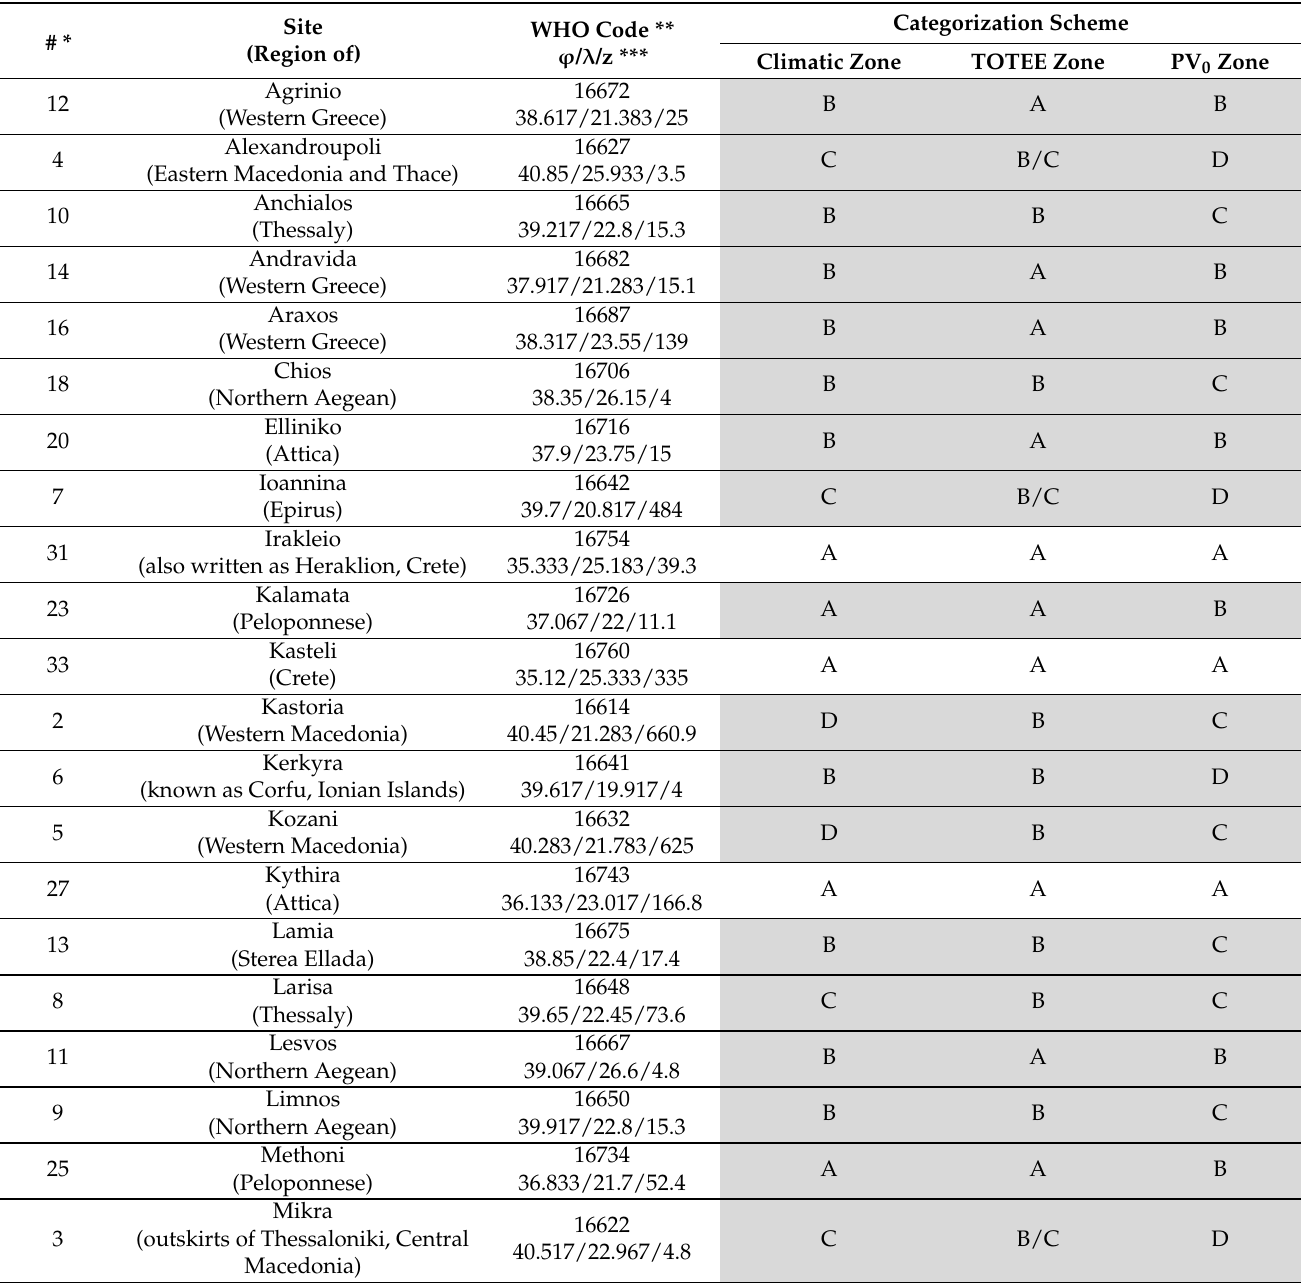
Table 3. Classification of the 33 sites (in alphabetical order) in terms of the received solar irradiation on a horizontal plane over a year. The classification schemes are the climatic zones based on the map of Figure 1, the TOTEE zones from Table 2 (surface solar radiation (SSR) column), and the PV 0 zones derived from Figure 3b. The gray rows highlight the changes among the different classification